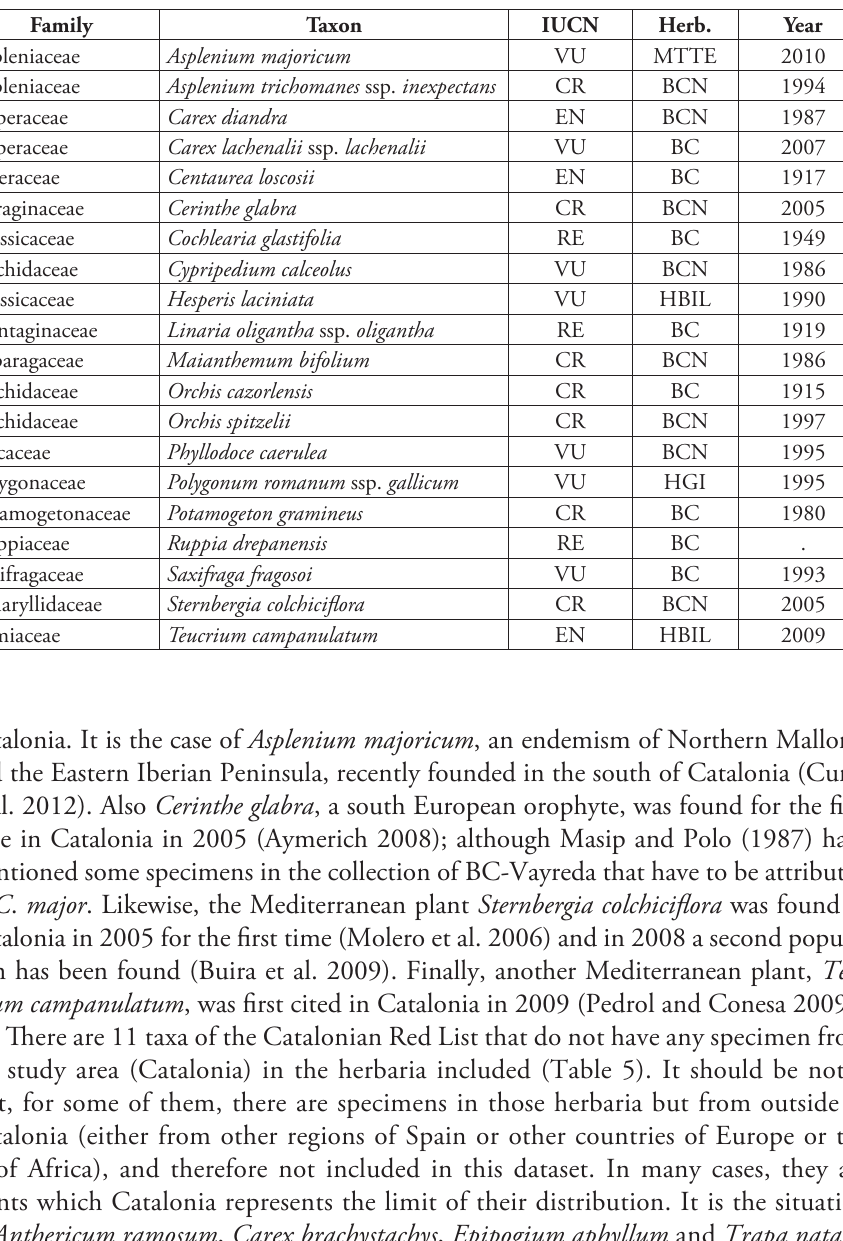
Table 4. Taxa with only one specimen. The herbarium and the collection year of each specimen are